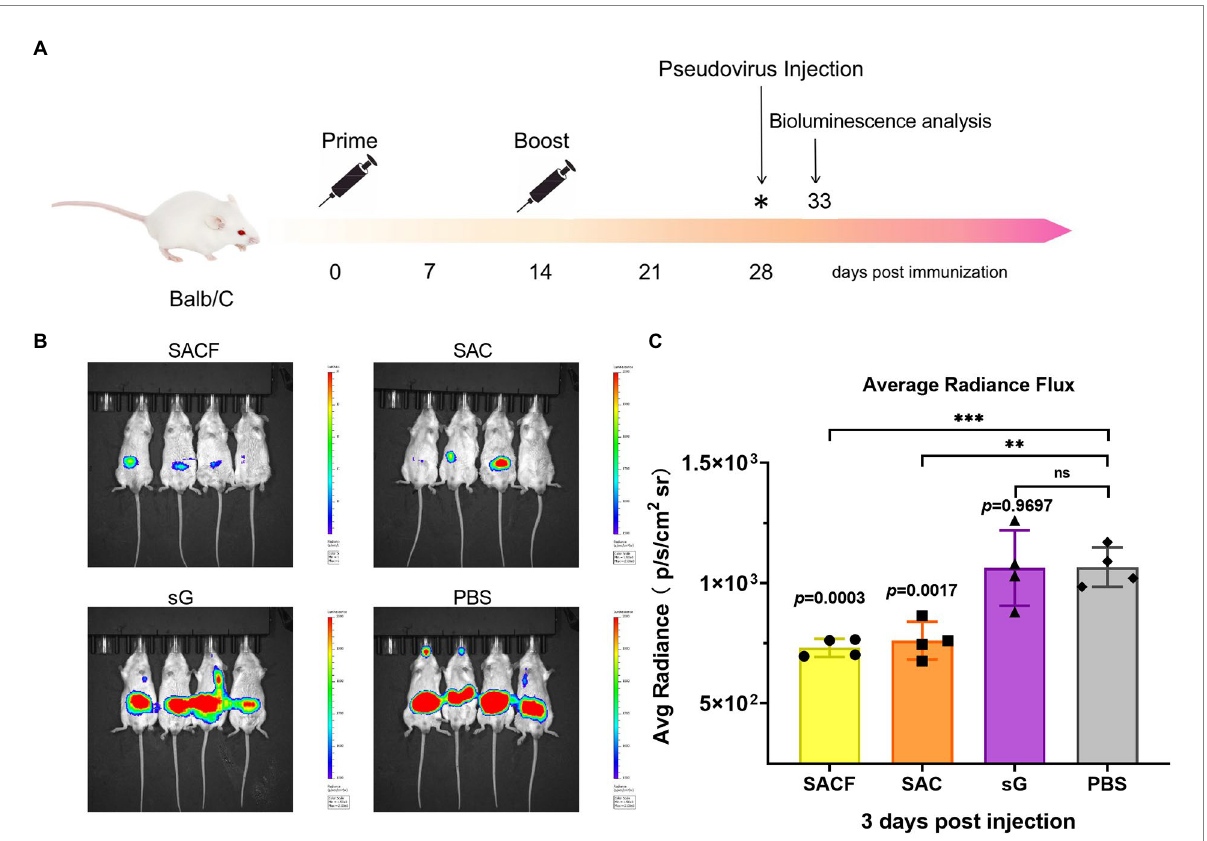
FIGURE 2 Protective effect of active immunization. (A) Process of immune protection in mice. The mice were divided into four groups: SACF, SAC, SG, and PBS control groups. Two immunizations were performed 2 weeks apart. NiV pseudovirus attack was performed 28 days after the initial immunization, and the pseudovirus dose for the in vivo infection test was determined as 50 AID50 (the 50% animal infectious dose), equivalent to a dose of 4.4 × 106 TCID50. The luminescent signal was detected 5 days after infection. (B) Detection of luminescence signal in each male mouse. Mice immunized with PBS were used as controls. The intensity represented the degree of NiV pseudovirus infection. (C) Average radiance flux data were statistically generated in the IVIS Lumina III imaging system, representing the mean intensity of the pseudovirus infection signal. The flux signals in each group were compared with those in the PBS control group using the Student t test (* p < 0.05, ** p < 0.01, *** p <